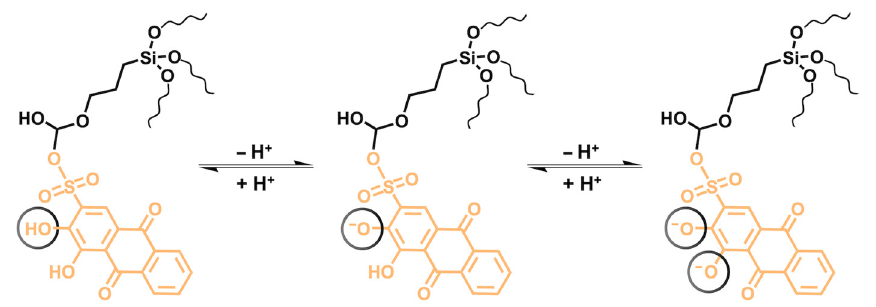
Scheme 2. Alizarin red S resonance structure at different pH values corresponding to neutral, mono-anionic and di-anionic forms.